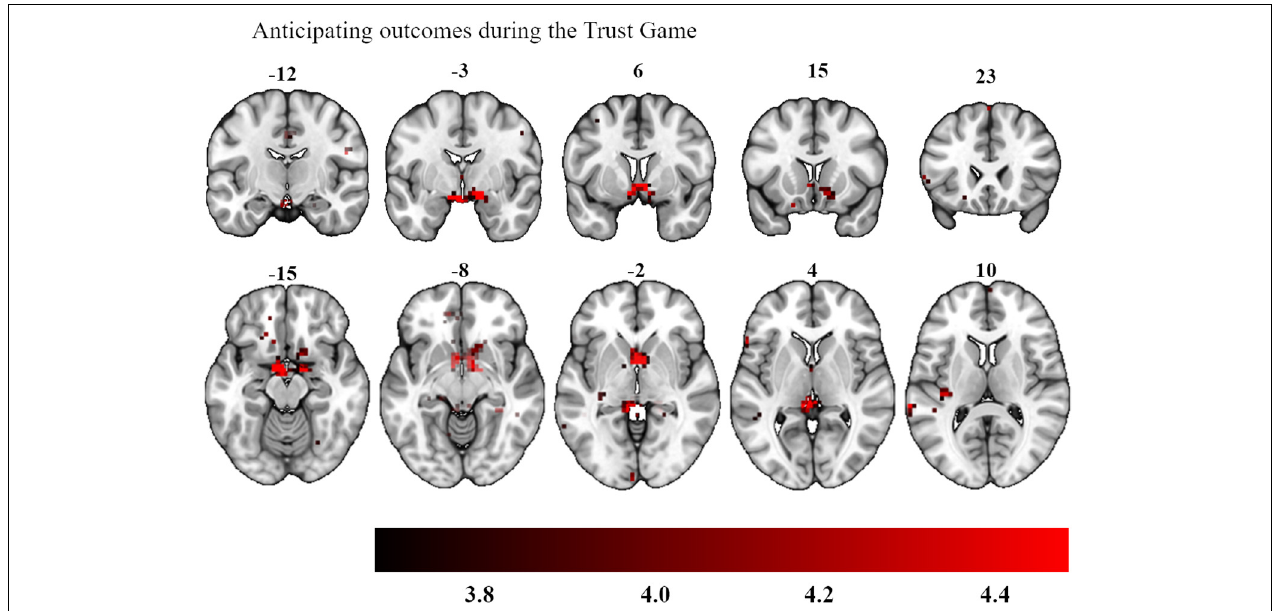
FIGURE 5 | Bilateral activation in the ventral striatum as a function of participants’ investment choices during the anticipation of their social outcomes. The color map defines the strength of the contrast’s T -scores (Statistical maps with an initial threshold of uncorrected p < 0.001 were established and were subsequently corrected for multiple comparisons using a Family Wise Error corrected cluster threshold of p <